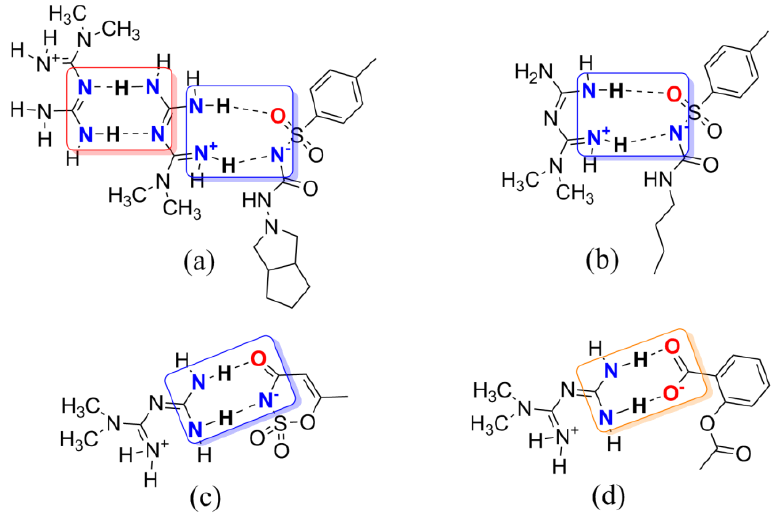
Figure 2 . Several examples of multicomponent chemical structures: ( a ) gliclazide metformin; ( b ) amino-methaniminium(butylcarbamoyl)(4-methylbenzene-1-sulfonyl)azanide; ( c ) metformin acesulfame; ( d ) amino[(diaminomethylidene)amino]- N , N -dimethylmethaniminium 2-(acetyloxy)benzoate. Supramolecular homo- and/or heterosynthons A, B, and C are highlighted with red, blue, and orange boxes, respectively.